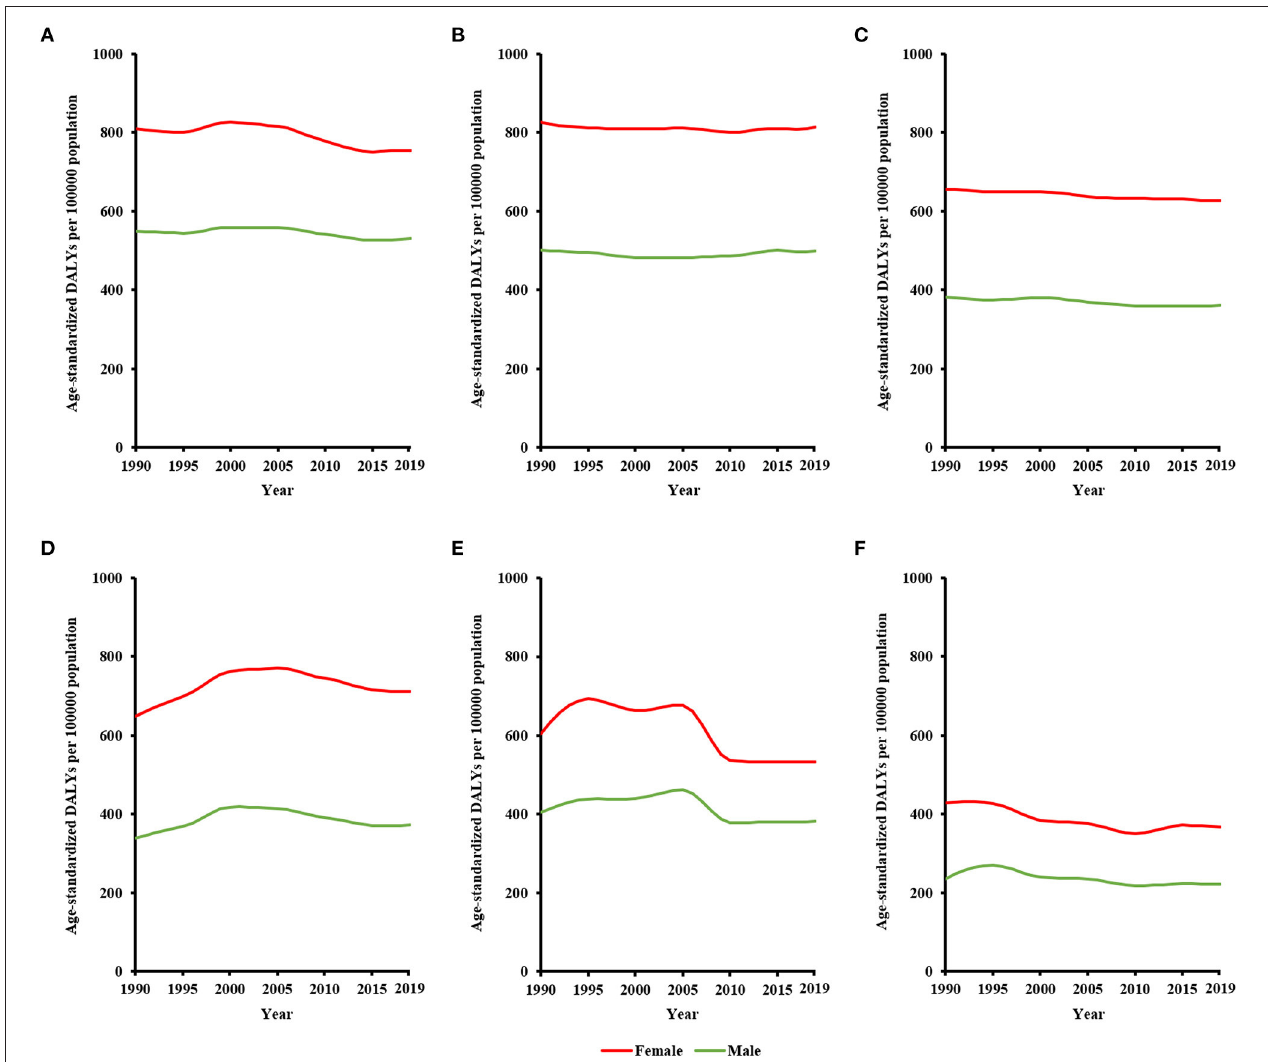
FIGURE 2 | Sex difference in WHO regional burden of major depressive disorder from 1990 to 2019, in terms of age-standardized DALY rates: (A) African region, (B) Eastern Mediterranean region, (C) European region, (D) region of the Americas, (E) Southeast Asia region, and (F) Western Pacific region.